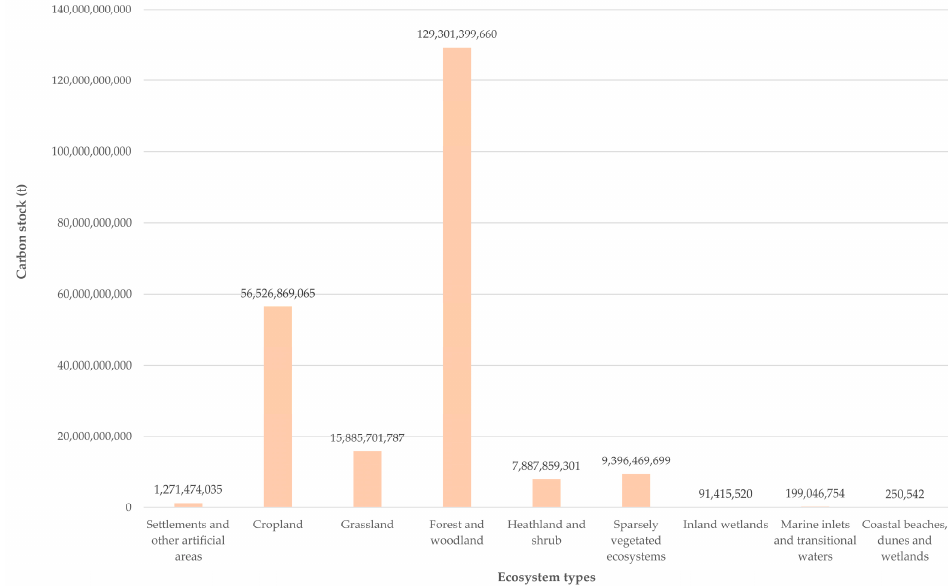
Figure 8. Carbon stock with respect to the types of ecosystems (2018). More than 99% of the crop production is concentrated in the “Cropland” and “Grass- land” classes, while marginal values can be found in “Forest and woodland” and “Sparsely vegetated ecosystems”.